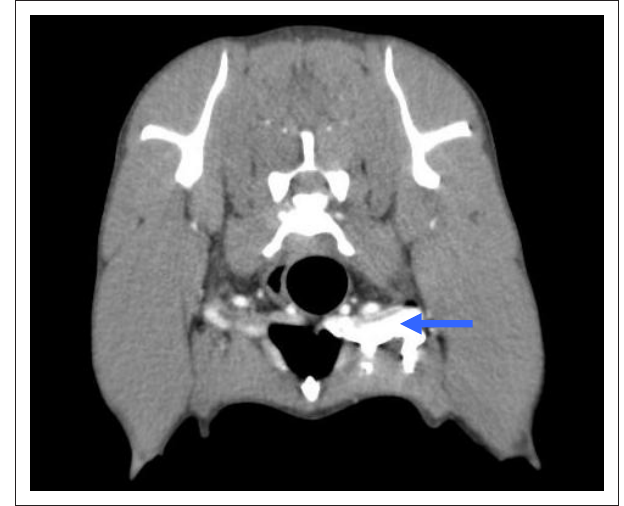
FIGURE 4: A transverse post-contrast image of dog 1 at the level of the cranial thoracic cavity, taken during the arterial phase of the BT